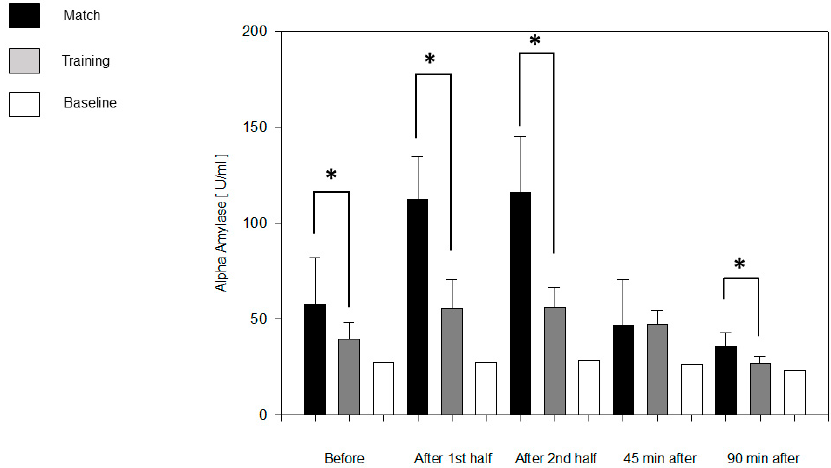
Figure 4. Salivary alpha-amylase (AA) values collected before, at halftime, directly after, and 45 and 90 min after, for the match, training, and the baseline with significant differences between match–training time points indicated with